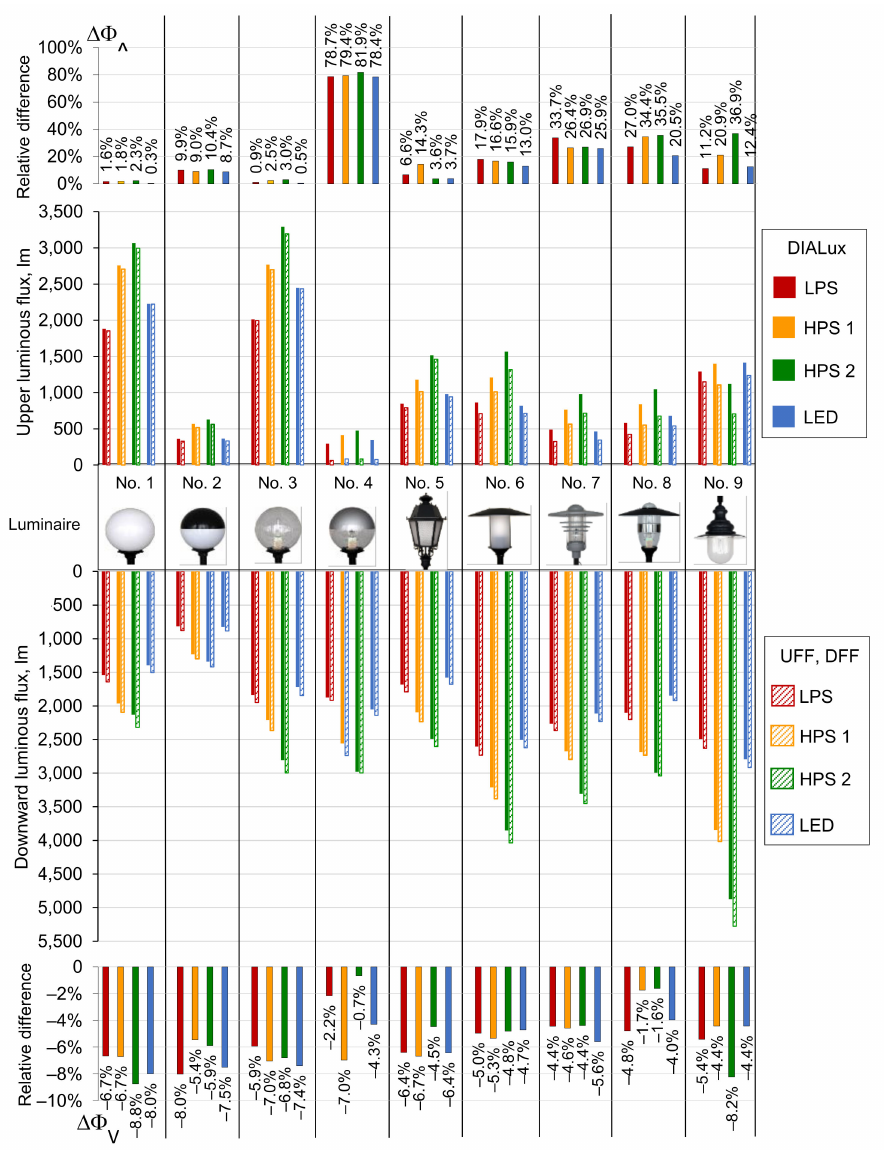
Figure 8. Calculated values of the luminous flux emitted into the upper and lower half-space by the luminaires cooperating with the various light sources